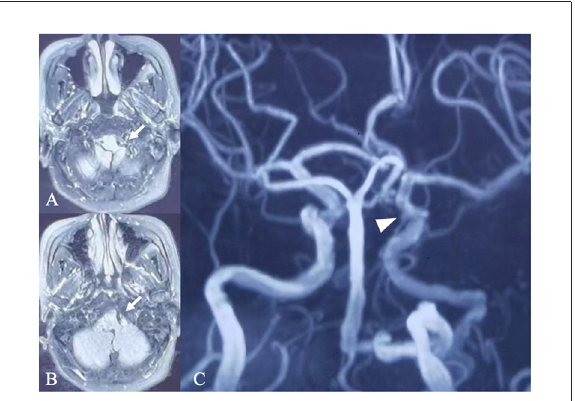
FIGURE1 Magnetic resonance imaging and angiography. (A) Magnetic resonance imaging (A,B) and magnetic resonance angiography (C) performed in a local hospital showed a left persistent primitive hypoglossal artery converging into the proximal part of the basilar artery (arrow) and aneurysm of the left posterior communicating artery segment of the ICA (arrow